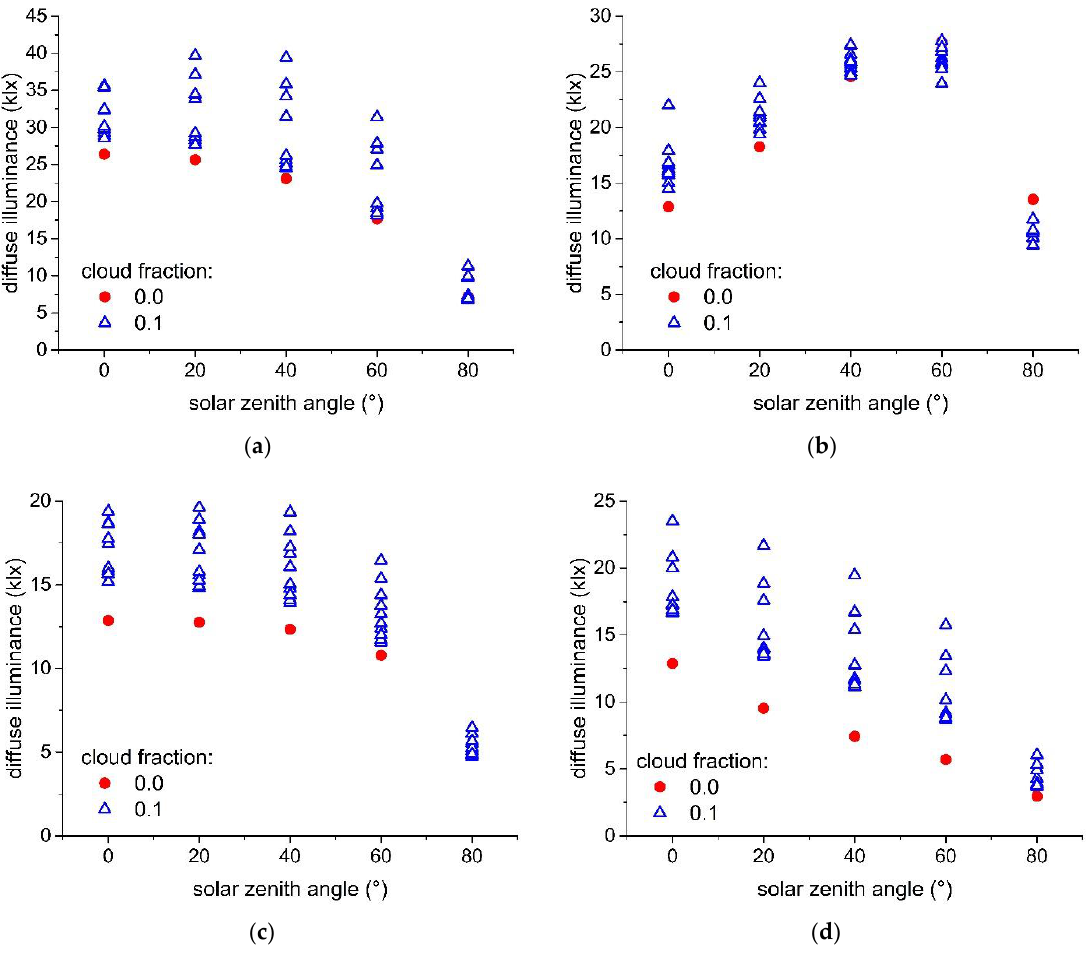
Figure 2. Diffuse illuminance on the horizontal plane ( a ) and vertical planes oriented to the south ( b ), east ( c ), and north ( d ) as a function of the solar zenith angle calculated for ten random distributions of identical clouds with the cloud fraction equal to 0.1.